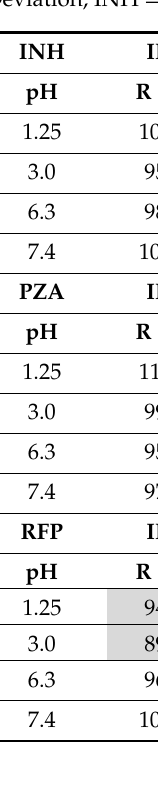
Table 2. Percentage of INH, PZA and RFP remaining (R%) after 0.75 h storage at di ff erent pH